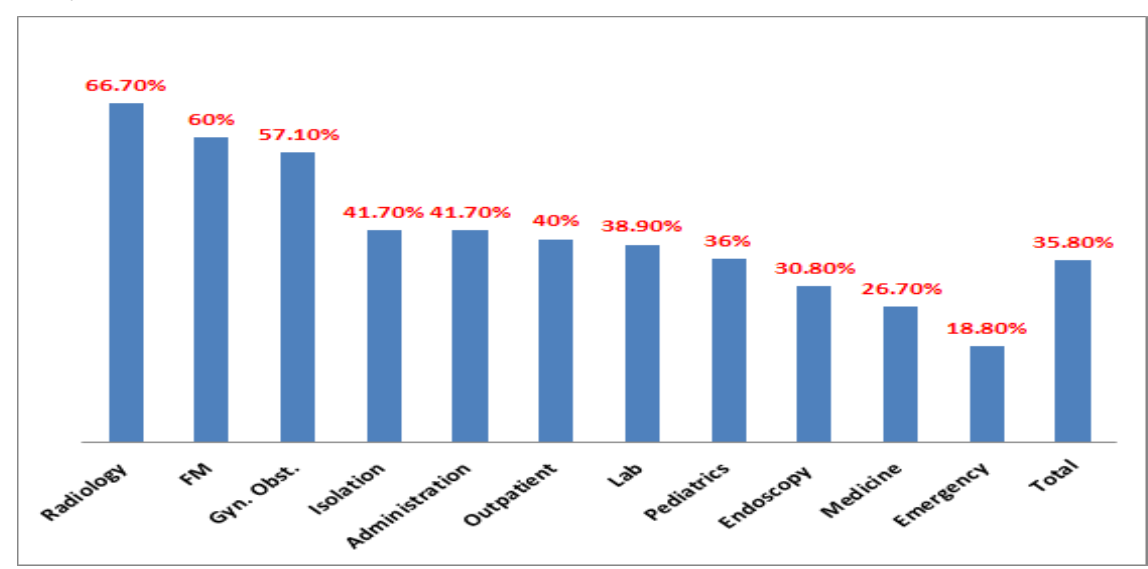
Figure 1. The incidence of anti-SARS CoV2 antibodies among the studied health care according to specialty or workplace.